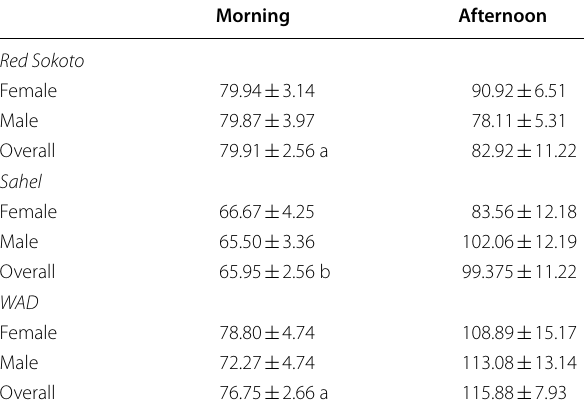
Table 2 Effects breed and sex on diurnal variation in respiratory rate (cycles per min.) of neonatal tropical goats